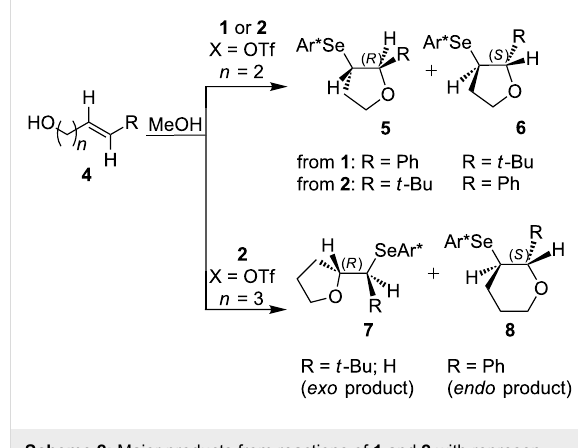
Figure 4: Plot of log k rel versus HOMO shows data grouped by branching at α position. Data are from Table 3; point numbers corres- pond to entries in Table